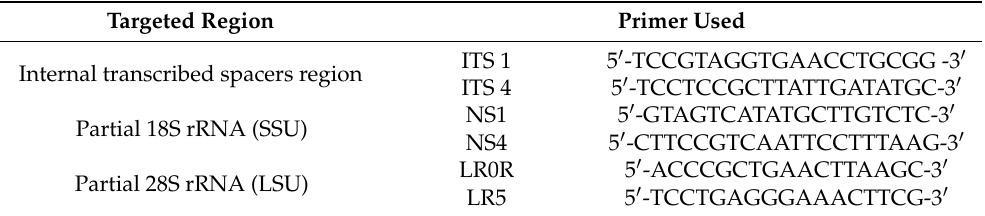
Table 1. List of primer pairs selected for fungal DNA fragments amplification. Targeted Region Primer Used Internal transcribed spacers